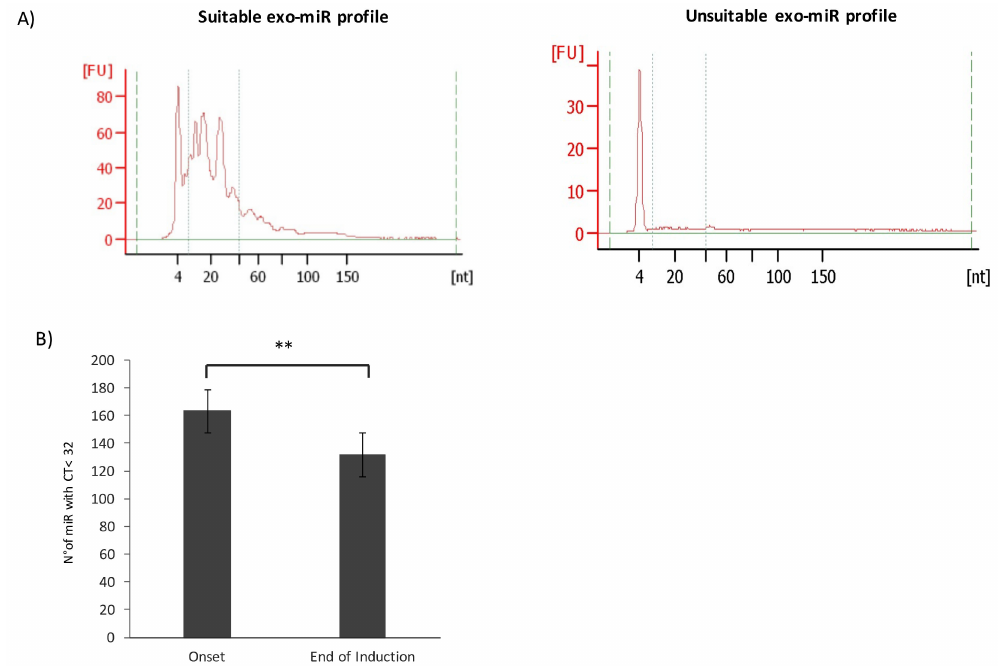
Figure 2. Exosomal (exo)-miRNAs expression in plasma samples. ( A ) Results of capillary electrophoresis, performed with the small RNA assay (Agilent 2100 Bioanalyzer), show the adequate exo-miRNAs profile of a representative NB patient and an unsuitable exo-miRNAs profile. The miRNAs region goes from 10 to 50 nucleotides included between the dotted lines. The Y-axis represents the fluorescence units [FU] and the X-axis reports the length of RNA molecules in nucleotides [nt]. (B ) The bar chart shows the average number of detected miRNAs (CT value < 32) in plasma exosomes at the onset and at the end of treatment. Error bars represent SD, ** p <